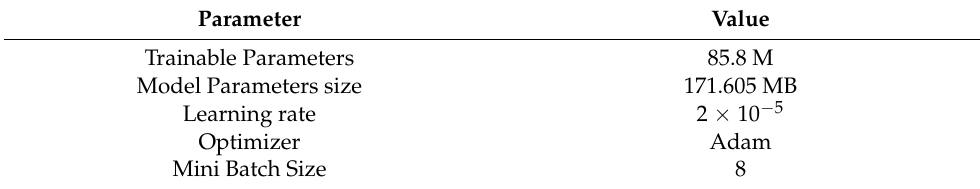
Table 1. Model complexity and hyperparameters.